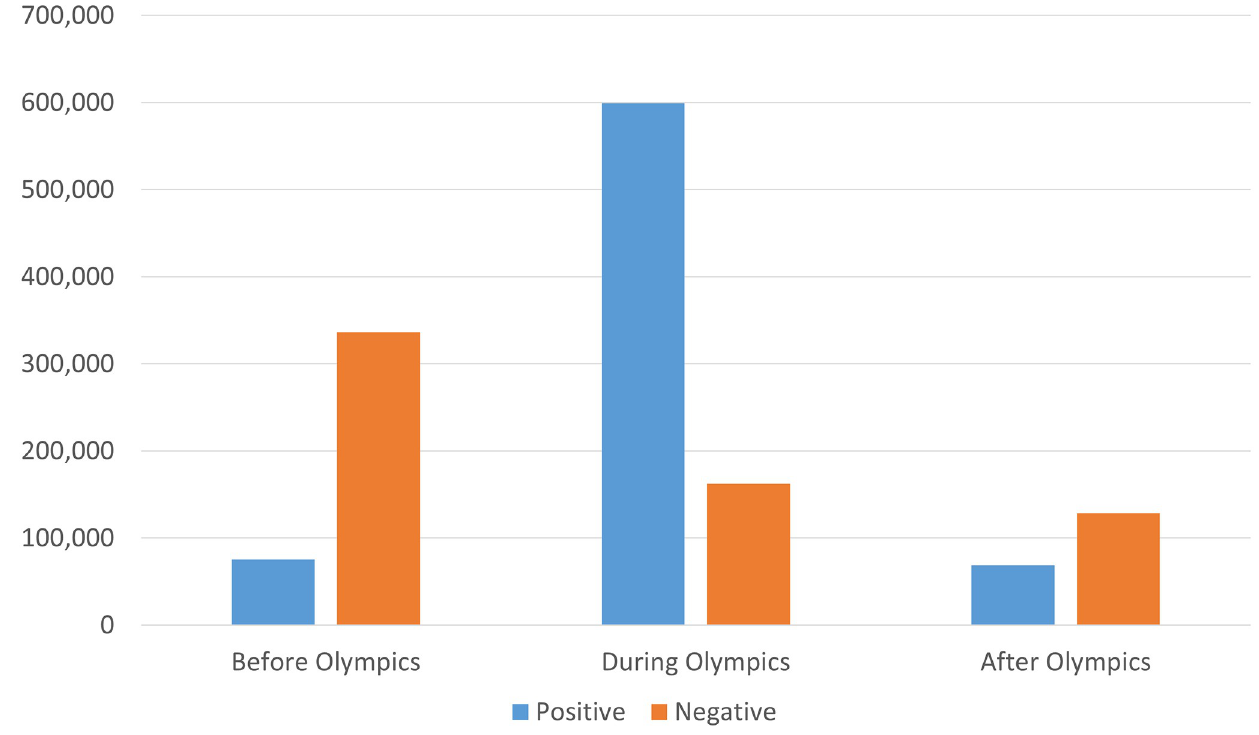
Fig 1. Number of users who posted positive/negative (re)tweets about the Olympic Games in each period.